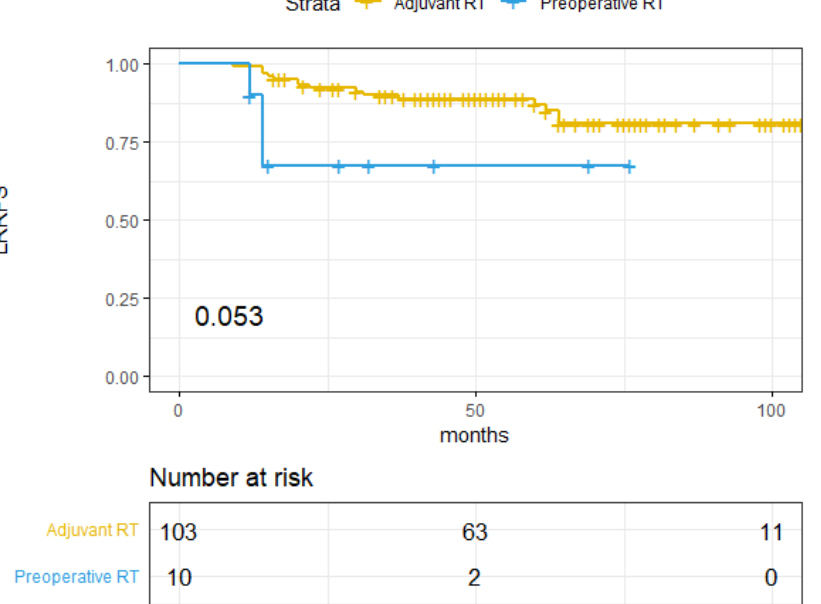
Figure A1. LRRFS with adjuvant radiotherapy (5-y LRRFS: 87.0% [80.2–94.4%]) vs. with preoperative radiotherapy (67.5% [43–100%]).